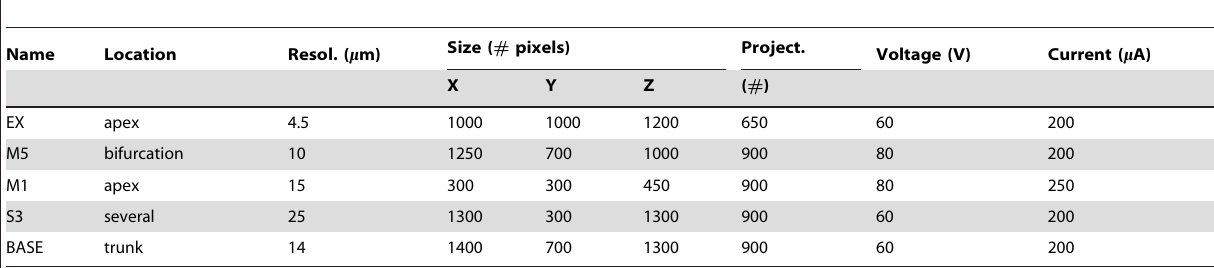
Table 1. Parameters of the image